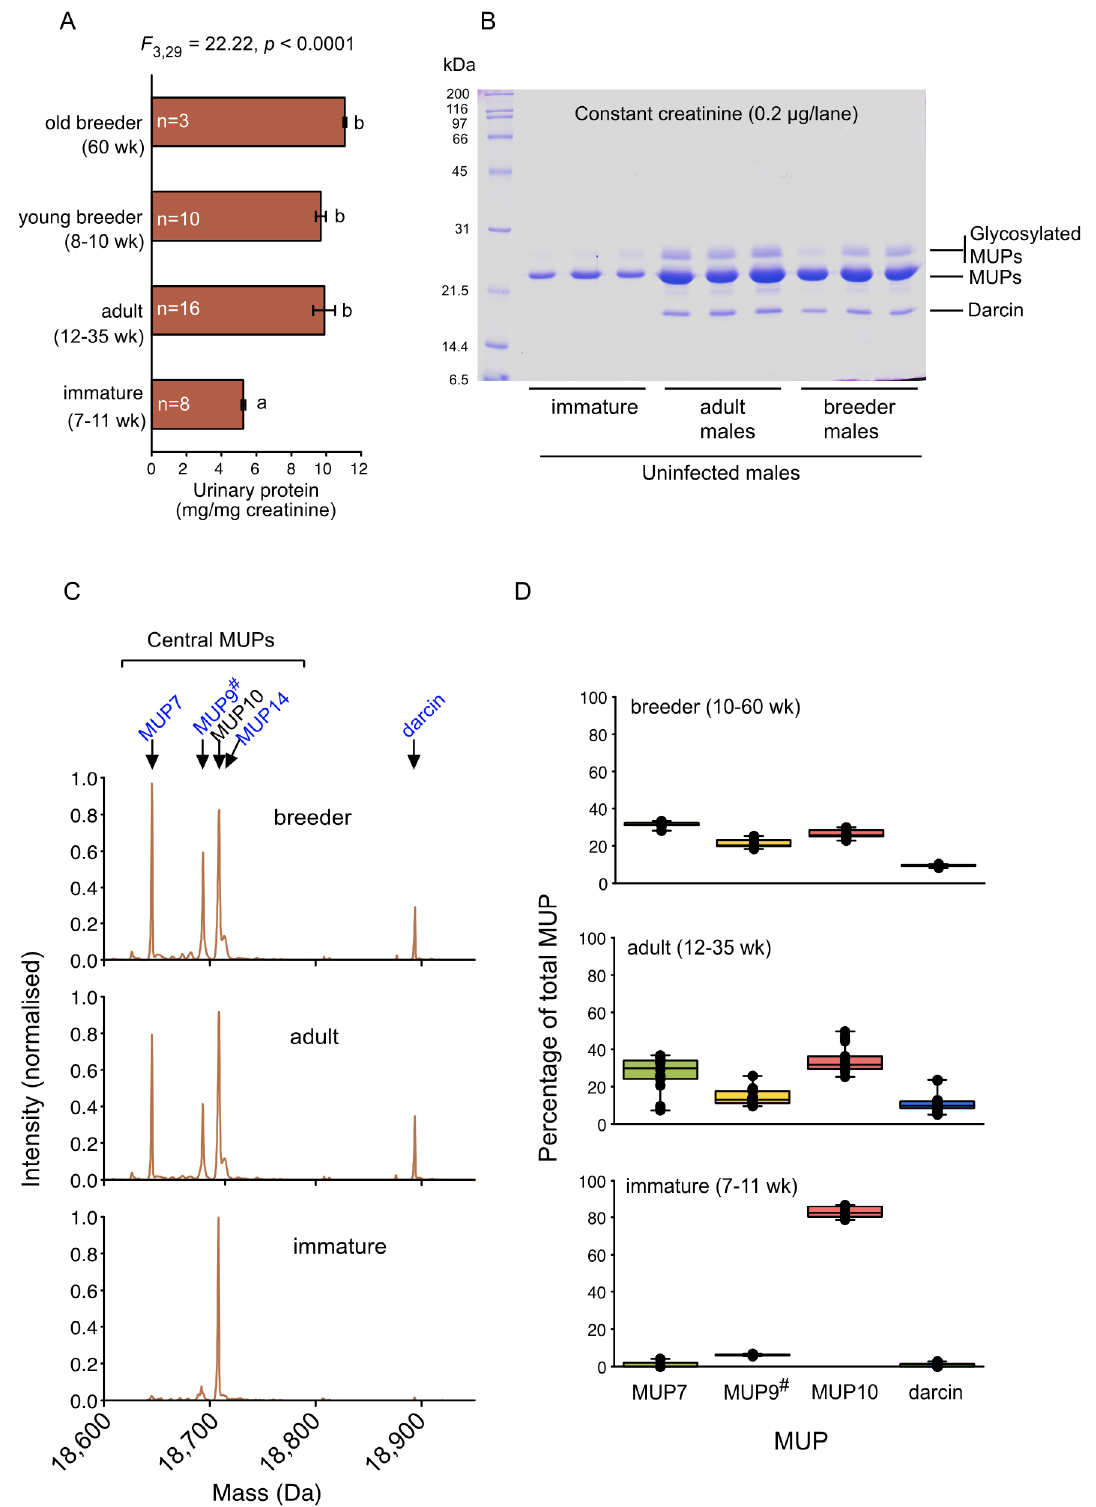
Figure 1. Urinary MUP output in urine of uninfected C57BL/6 male colony mice. ( A ) Total urinary protein output for a sample of immature and mature adult males housed in single-sex groups or with females for breeding. Protein is normalised to creatinine in urine to correct for variance in urine dilution. Different letters (a,b) indicate a significant difference between groups according to Bonferroni post-hoc comparisons ( p < 0.0005). ( B ) Visualisation of urinary protein on reducing SDS PAGE, revealing the major MUP band, a high mobility darcin band, a slower mobility band of glycosylated MUPs and the absence of any other major protein bands in the urine samples (immature males aged 7 weeks; adult males aged 12, 19 or 26 weeks; breeder males aged 8, 10 or 60 weeks). ( C ) Resolution of MUPs by ESI-MS. The plots are deconvoluted